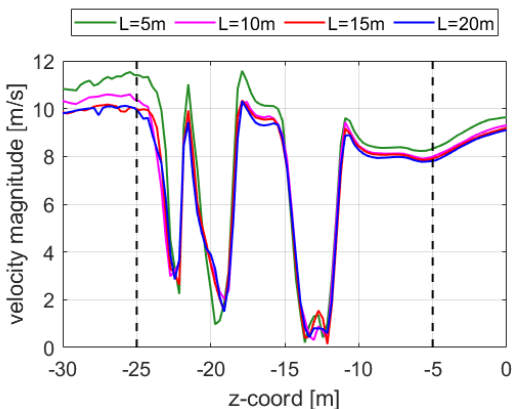
Figure 3. Velocity profiles along line 1 for different L values. The portion of the velocity profile between the black dashed lines impacts the platform.